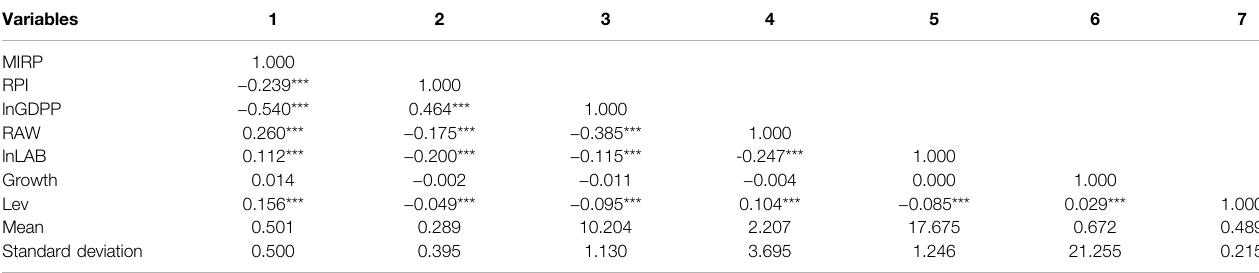
TABLE 7 | Descriptive statistical results and correlation analysis.